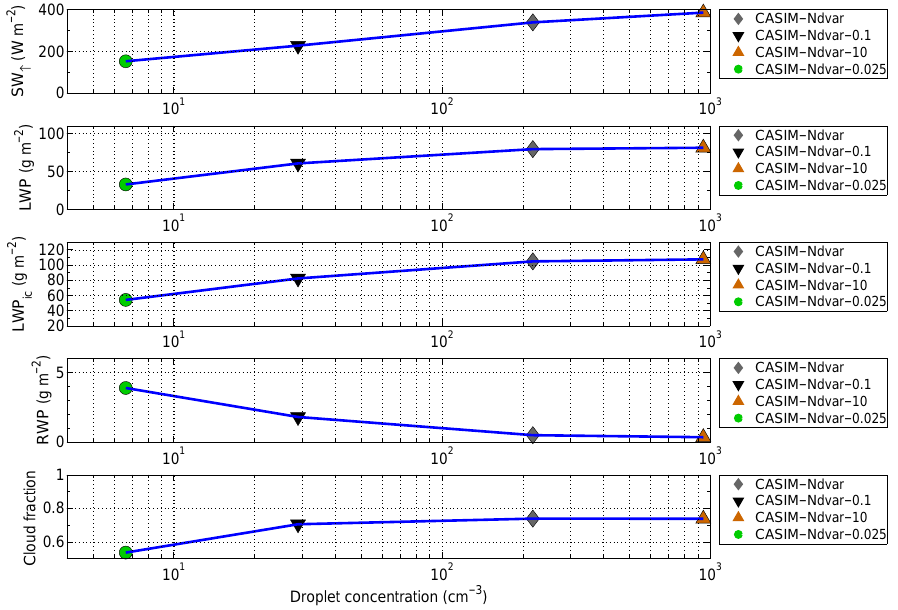
Figure 15. Summary plots of domain- and time-mean quantities for the different model runs. The time average is weighted by the incoming SW TOA flux time series to give extra weighting to times when the cloud properties contribute to the SW flux, i.e. mainly in the daytime. The x axis shows droplet concentrations, which are calculated in the same way as for Fig. 3. The top plot shows SW TOA flux, which is followed by LWP (domain mean), in-cloud LWP (LWP ic ), RWP, and cloud fraction. Cloud fraction is calculated as for Fig. 10. Model data at 30min intervals between the times of 06:00UTC (01:12LST) on 12 November and 00:00UTC (19:12LST) on 14 November are used, with the first 6h of model data being avoided due to